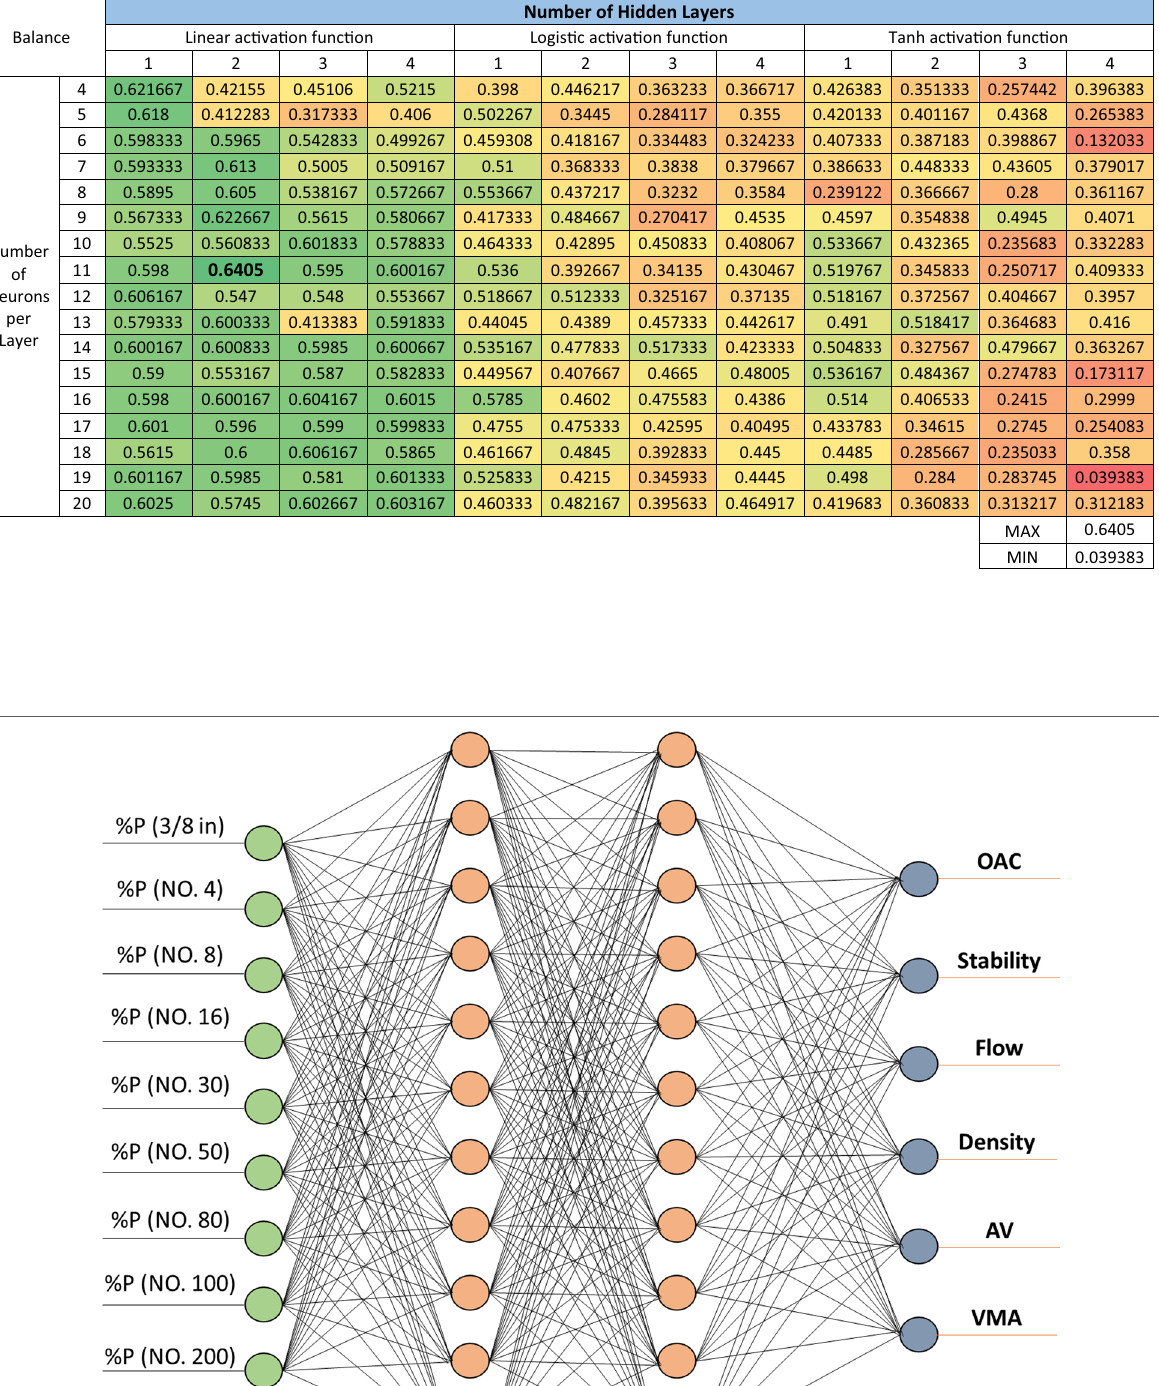
Table 9 Balanced coefficient of correlation for different ANN architectures Balance